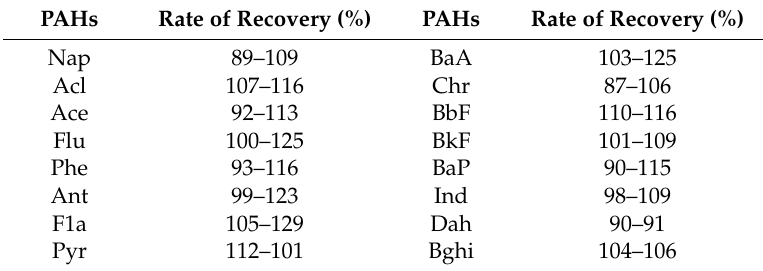
Table 1. Recovery efficiencies of 16 polycyclic aromatic hydrocarbons